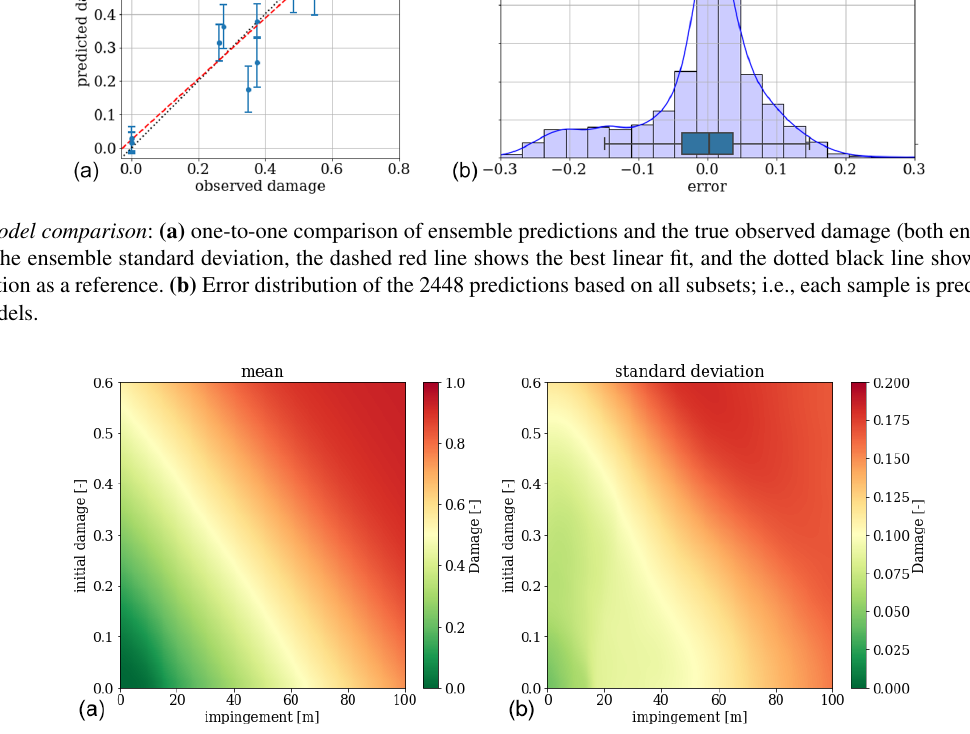
Figure 13. Probabilistic results : (a) color maps used as physicality checks to verify the ensemble model response across the two-dimensional input space. Panel (b) shows the ensemble mean, and the right figure shows the ensemble standard